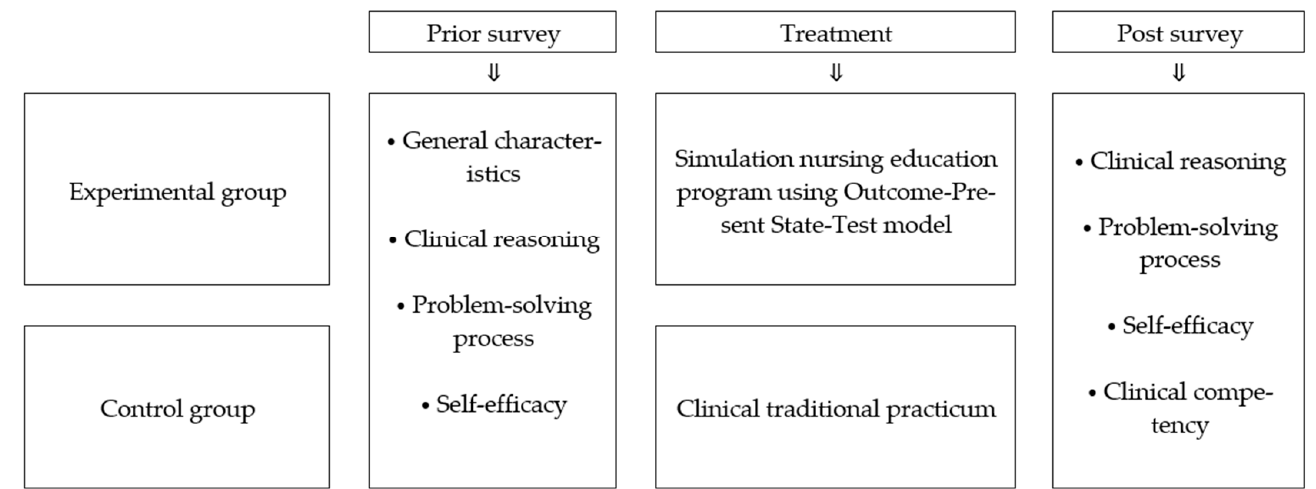
Figure 1. Research design.